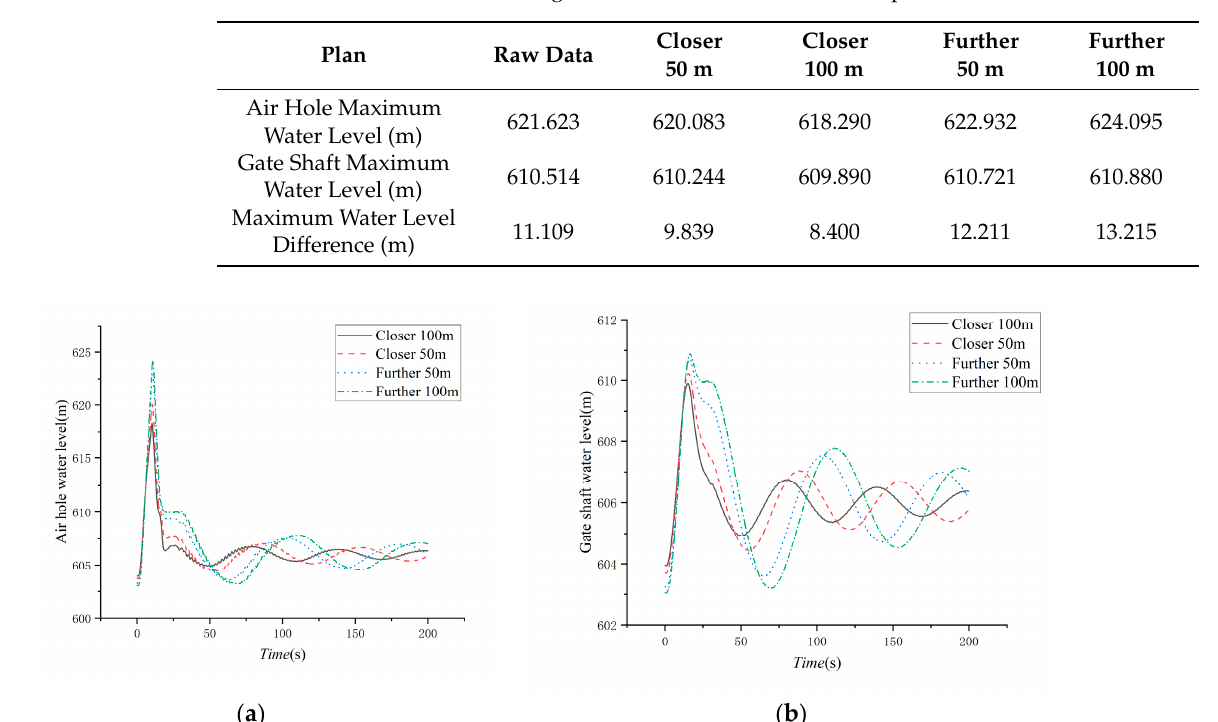
Table 8. Maximum water level of gate shaft and air hole at different positions.